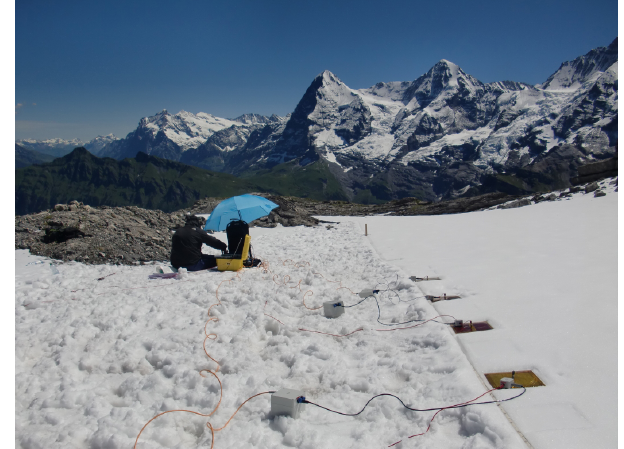
Figure 2. Photograph of the measurements at profile B-SCH (Schilthorn area) in July 2016 with the Chameleon measurement device. The four plate electrodes are lying in line on the snow sur- face. The larger yellow box is the base unit which is connected by cables to the electrodes with the cubic grey remote units in